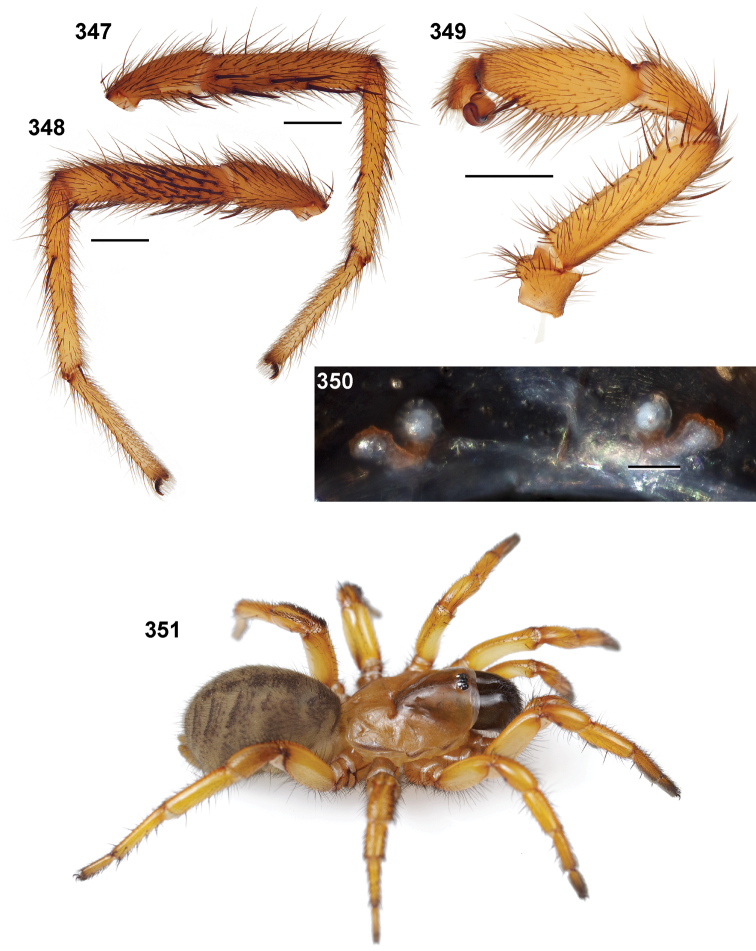
Aptostichus chavezi sp. n. from Tulare County. 347–349 male holotype (AP562); scale bars = 1.0mm 347 retrolateral aspect, right leg I [806401] 348 prolateral aspect, right leg I [806405] 349 retrolateral aspect, pedipalp [806407] 350 cleared spermathecae (AP1248) [806408]; scale bar = 0.1mm 351 female paratype (MY3774) from Tulare County, photographed in life.